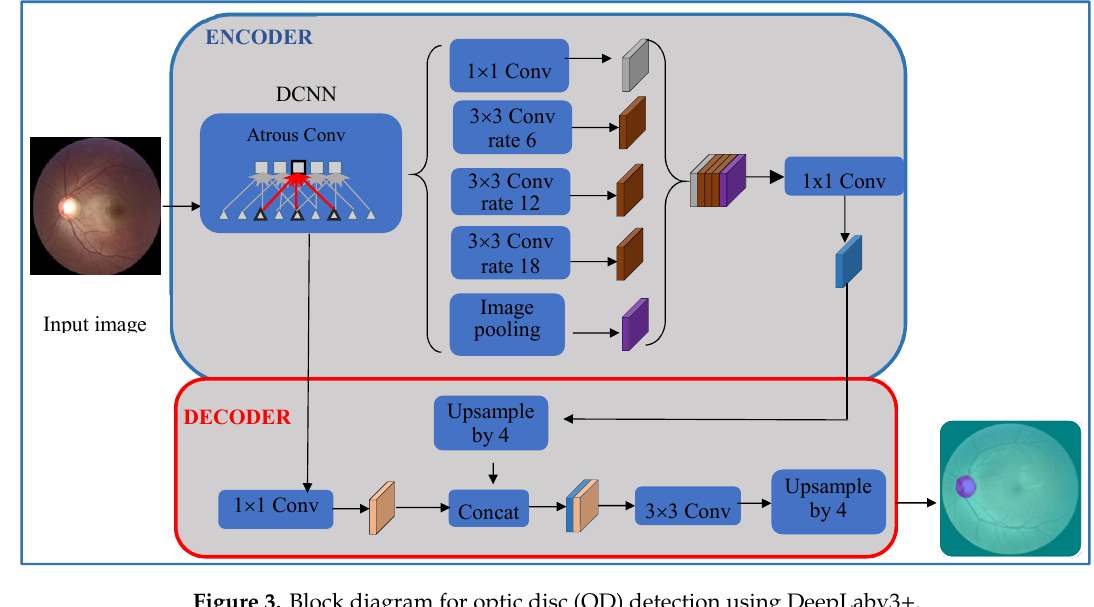
Figure 3. Block diagram for optic disc (OD) detection using DeepLabv3+.